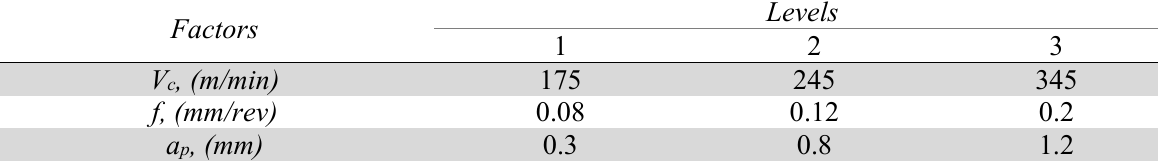
Mechanical properties of AISI 12L14